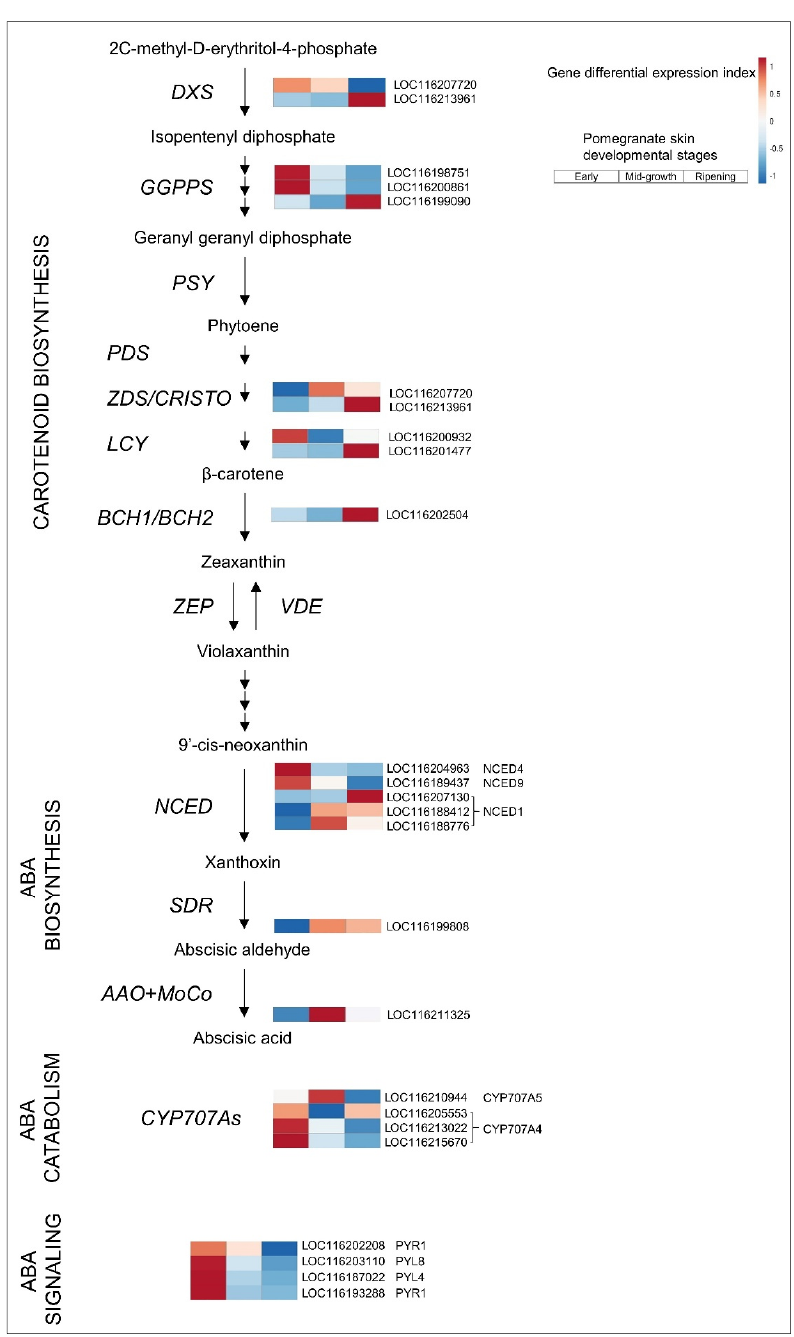
Figure 3. ABA metabolism in pomegranate skin. Illustration of the metabolic pathway combined with heatmap visualization of differentially expressed genes in the skin of early (left column), mid-growth (middle column), and ripening (right column) fruit. Genes involved in each metabolic step are represented by their respective gene IDs. The color index indicates upregulation (red) or downregulation (blue) of a gene relative to the group of genes putatively encoding the same function; expression level values and full gene names are given in Table S5.